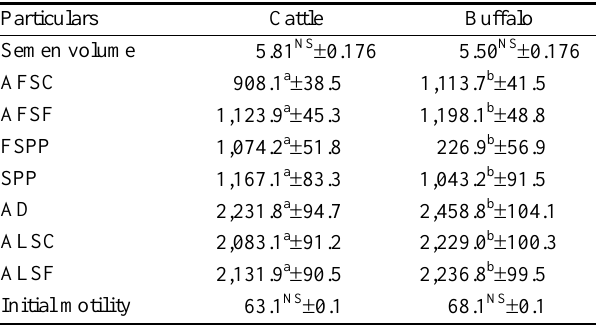
Table 6. Least squares mean  SE for semen volume, age at disposal, age at first semen collection, age at first semen freezing, frozen semen production period, semen production period, age at last semen collection, age at last semen freezing and